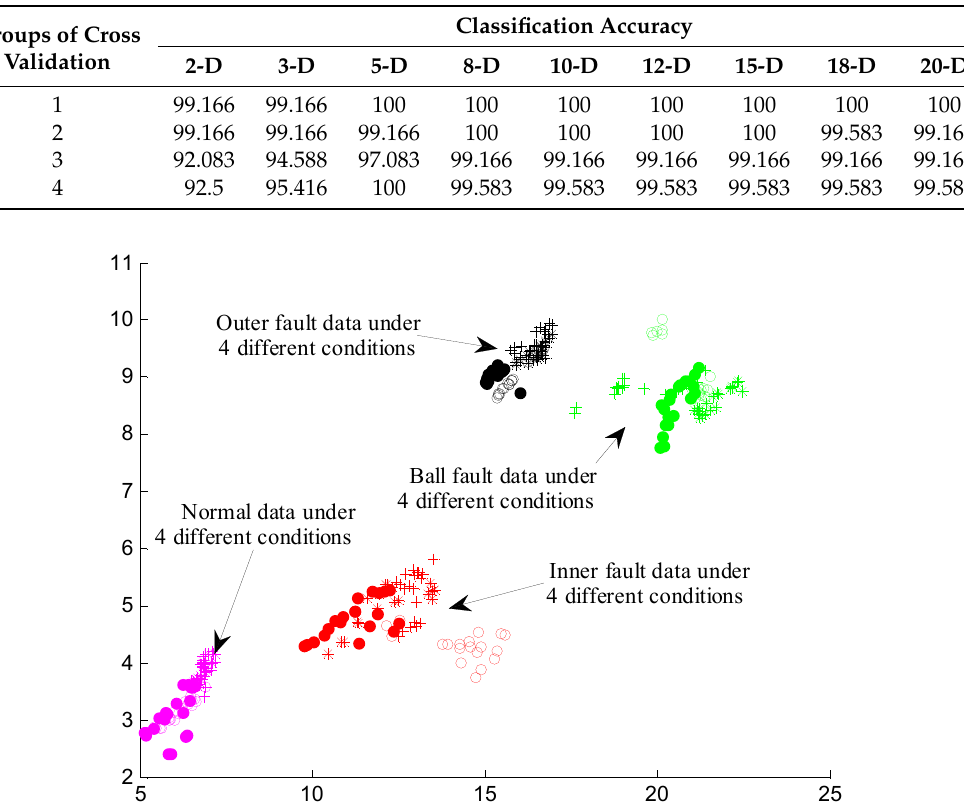
Table 4. Classification accuracy of the cross validation in different dimensionality.